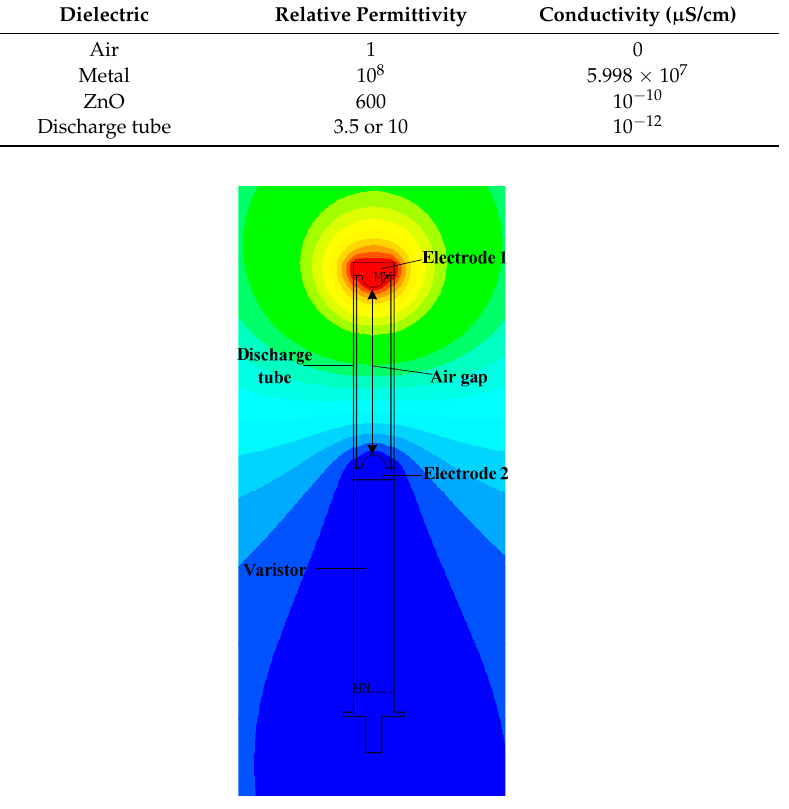
Figure 5. The results of impulse voltage experiment. Table 2. Physical parameters of the dielectric materials.